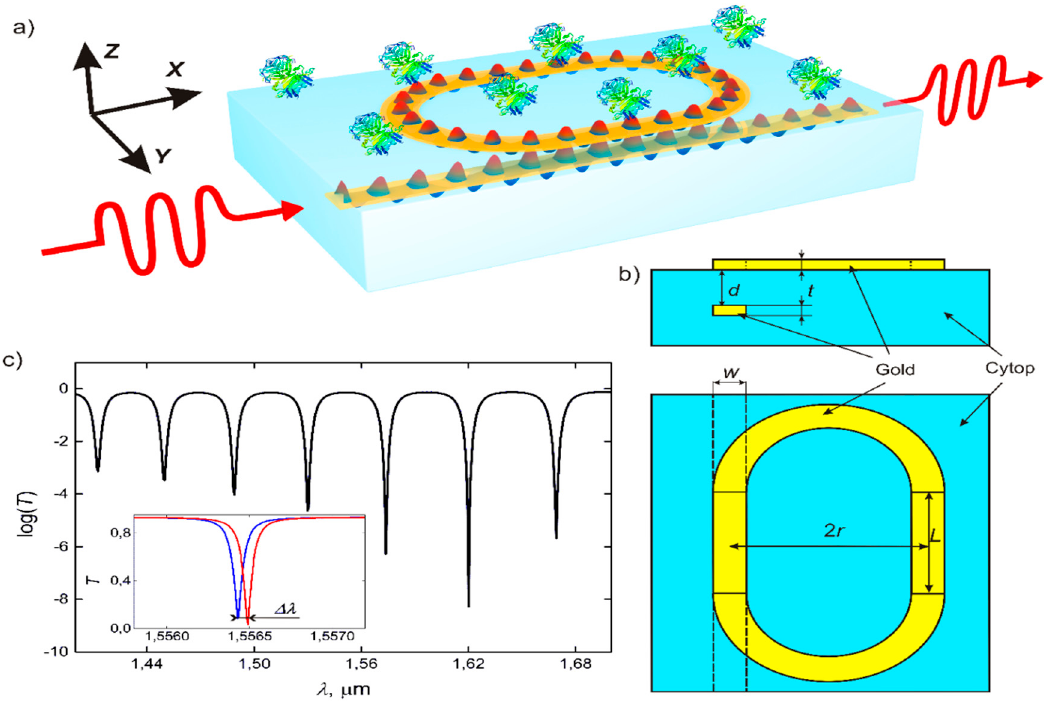
Figure 1. Scheme of the biosensor: ( a , b ) the long-range surface plasmon polariton (LRSPP) strip waveguide is located inside the dielectric. The resonator, which is the same waveguide closed in a ring, is located on top of the substrate, on the boundary with the test solution. ( c ) Dependence of logarithm of transmission through the system from the wavelength of the input signal. The shift of resonance curve that appears when the refractive index (RI) of the test solution above the resonator changes by 5 × 10 − 5 .